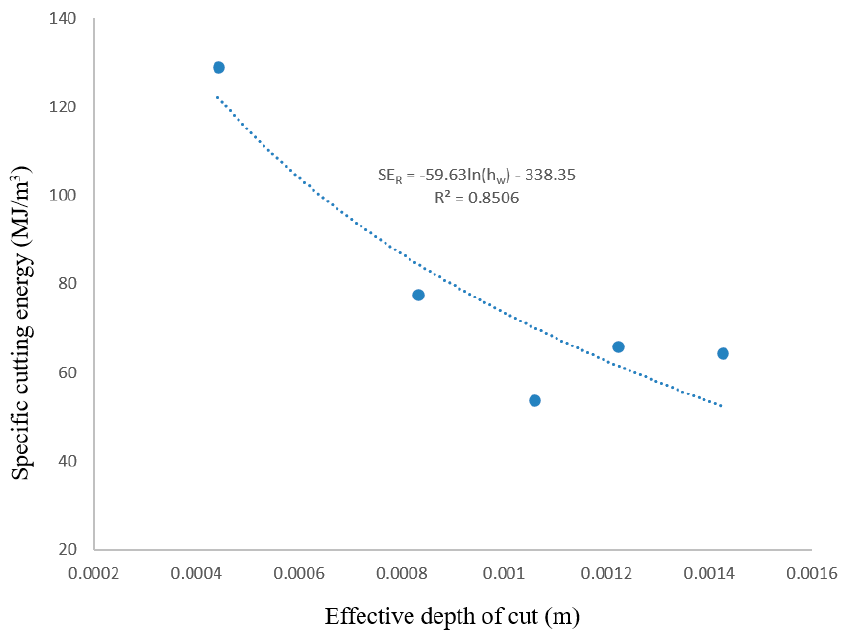
Figure 6. Diagram of the dependence of the specific cutting energy on the effective depth of cut.